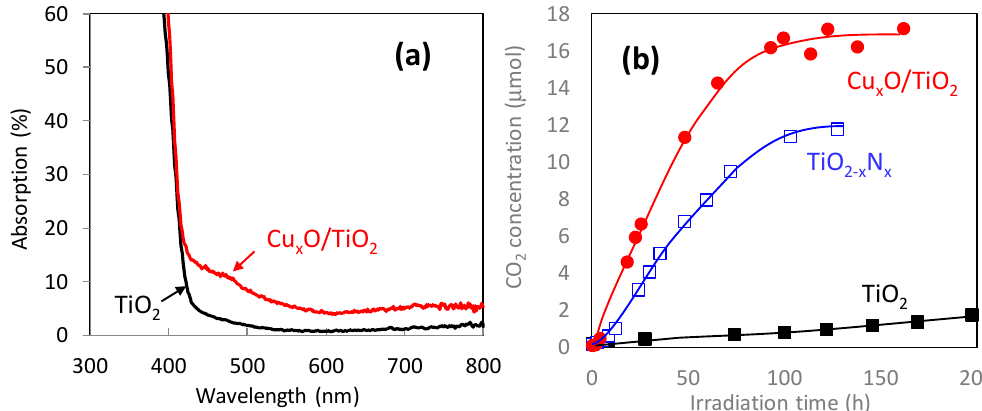
Figure 11. ( a ) Optical absorption spectra of TiO 2 (black line) and Cu x O / TiO 2 (red line). ( b ) Photocatalytic oxidation activities of 2-propanol under visible-light irradiation for bare TiO 2 (black), TiO 2-x N x (blue), and Cu x O / TiO 2 (red) [33]. Visible-light irradiation was conducted using a xenon lamp passed through optical filters to set the wavelength at 400–530 nm with an illuminance of 1 mW / cm 2 . The ratio of Cu(I) / Cu(II) in Cu x O was 1.3.